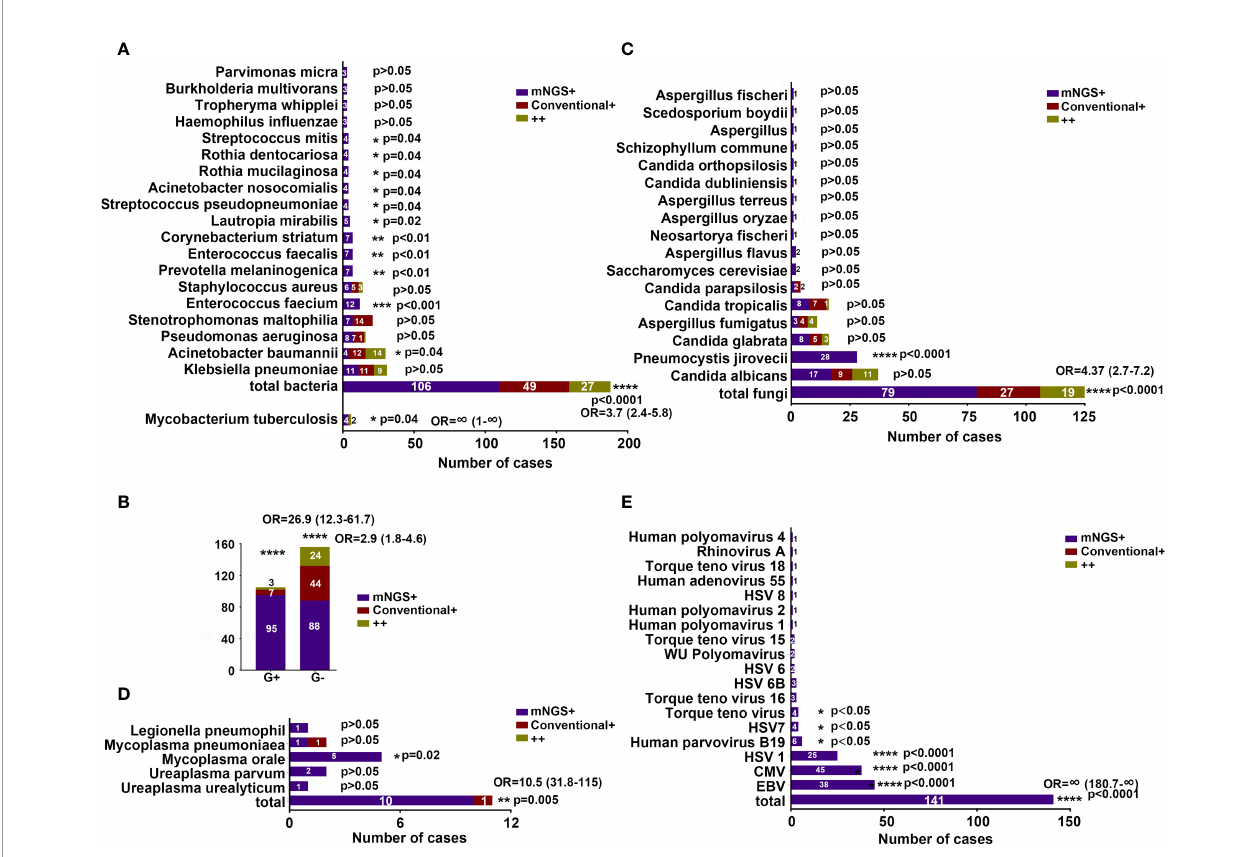
FIGURE 2 | Comparison of positive results by mNGS and conventional methods. (A) Comparison of MTB and bacterial positivity by mNGS and conventional methods. (B) Comparison of G+ and G − bacterial positivity detected by mNGS and conventional methods. (C – E) Comparison of fungal, atypical pathogen, and viral positivity detected by mNGS and conventional methods. * P < 0.05, ** P < 0.01, *** P < 0.001, **** P < 0.0001. OR, odds